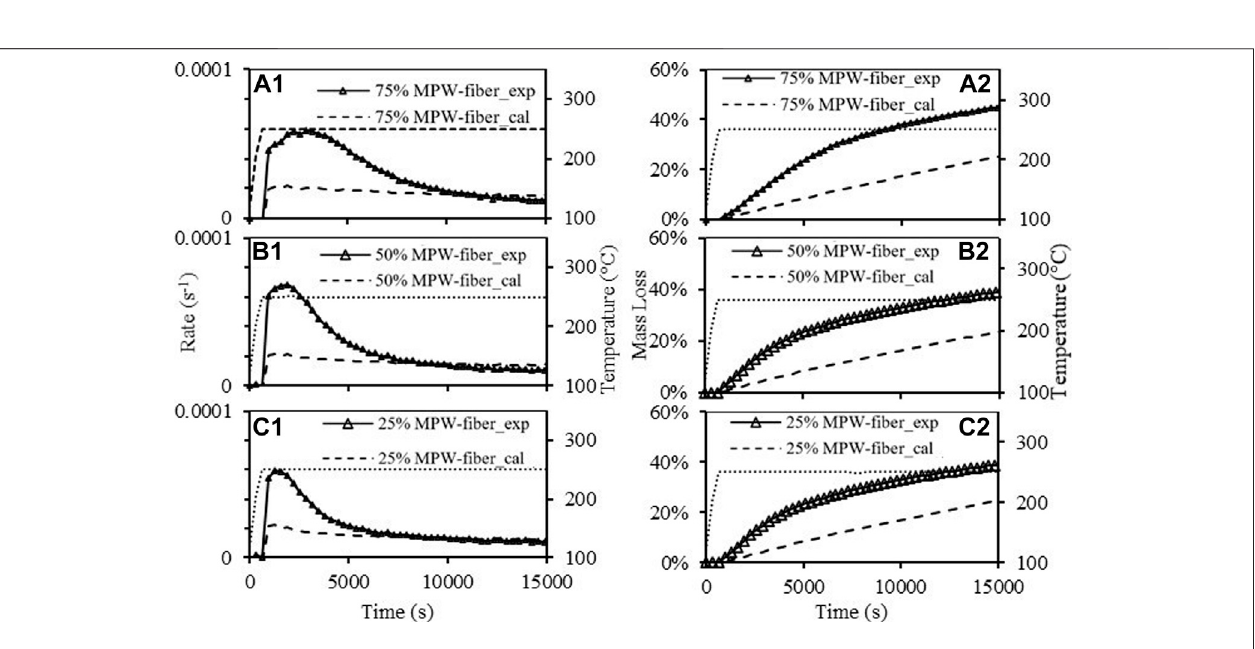
Frontiers in Energy Research |